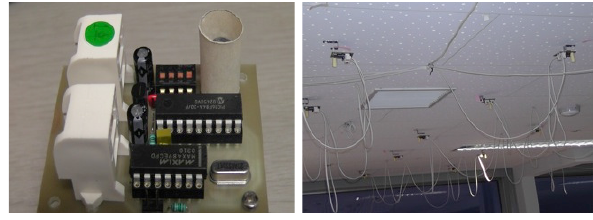
Figure 1. The sensor module and the interconnection of sensor nodes with